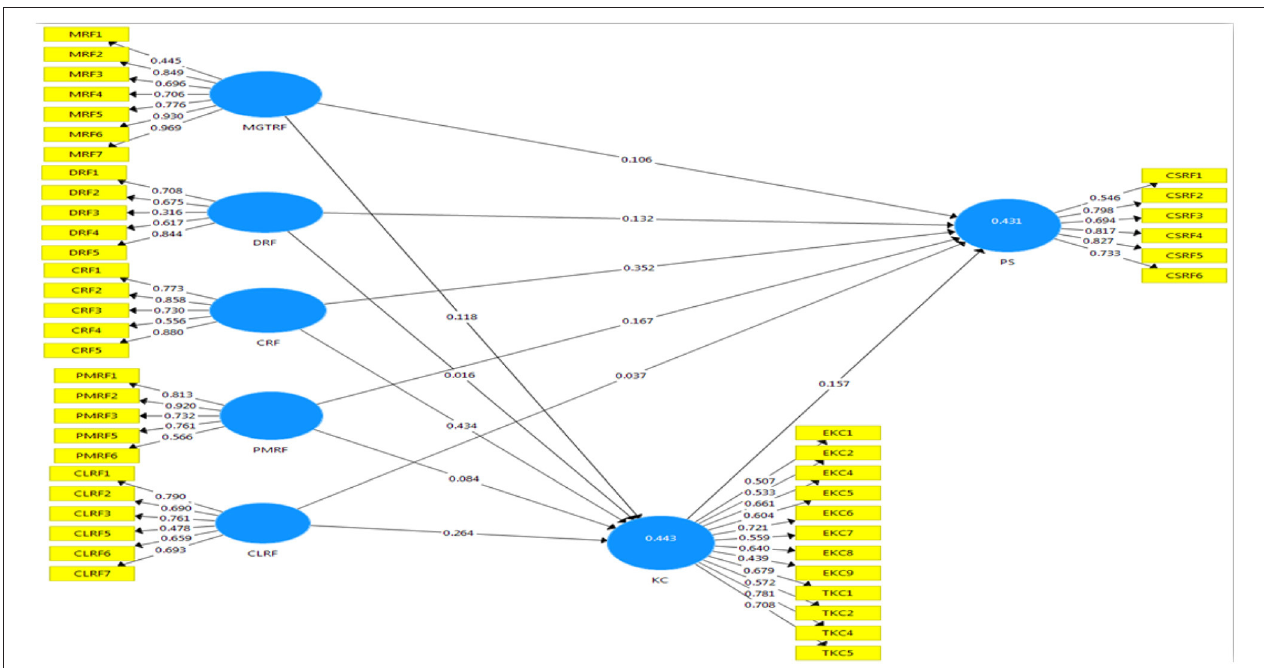
FIGURE 2 | Measurement model indicating only indicators reliability. Source: Author’s